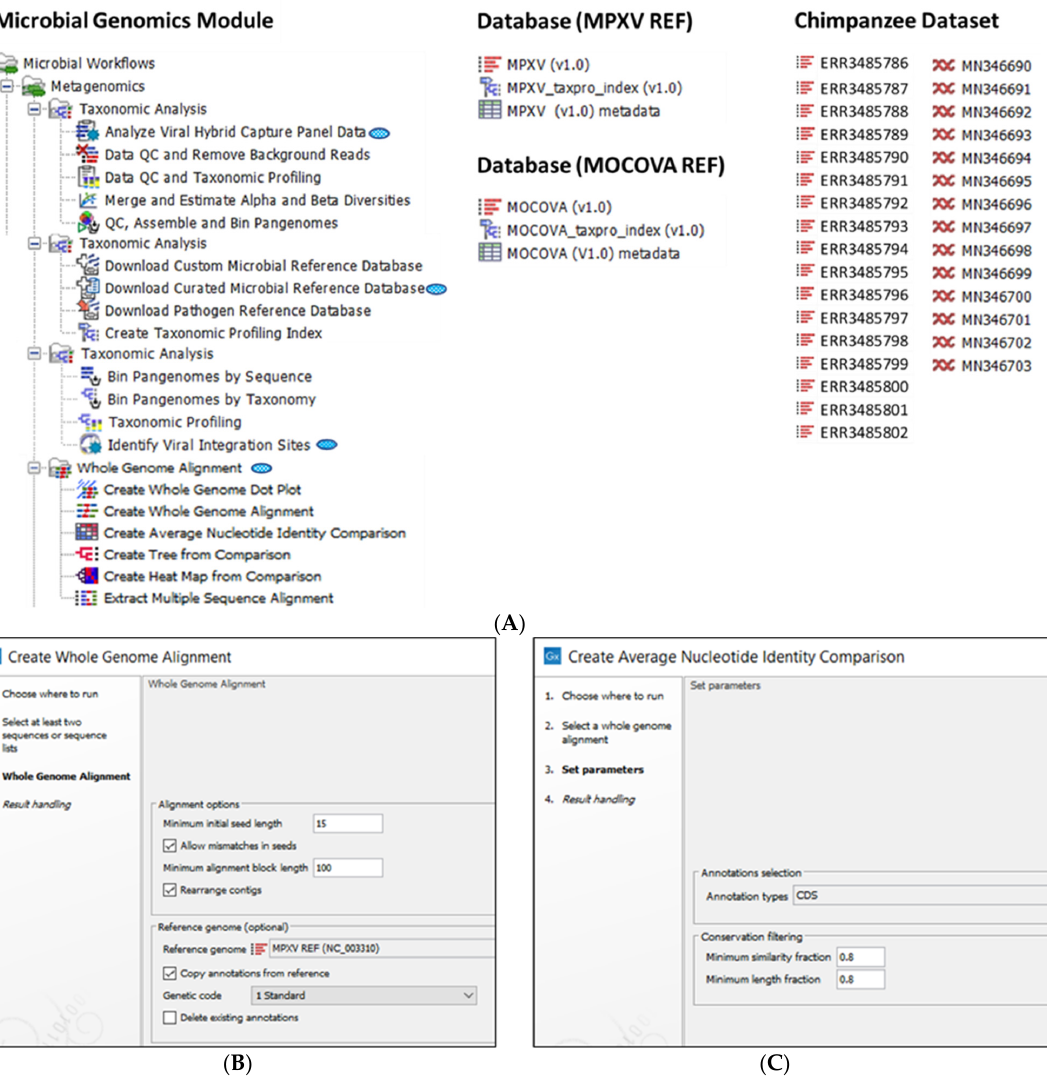
Figure 2. Bioinformatics methods ( A ) CLC Microbial Genomics Module, databases and dataset used for Monkeypox Virus (MPXV) Whole Genome Alignment (WGA) and comparative genomics. Primary workflows and tools used for this study are designated by the blue virus icon; ( B ) WGA workflow steps (1–4) with user-defined parameter settings for WGA (bold) and annotation, i.e., MPXV REF genome; ( C ) Create Average Nucleotide Identity Comparison workflow inputs the MPXV WGA file to quantify the similarity between genomes. The output is an autogenerated pairwise comparison